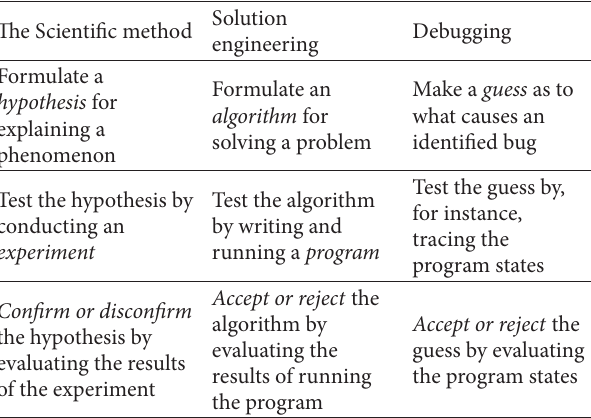
Table 1: Analogy between the scientific method, Colburn’s [43] “solution engineering,” and Bartley’s [44] view of